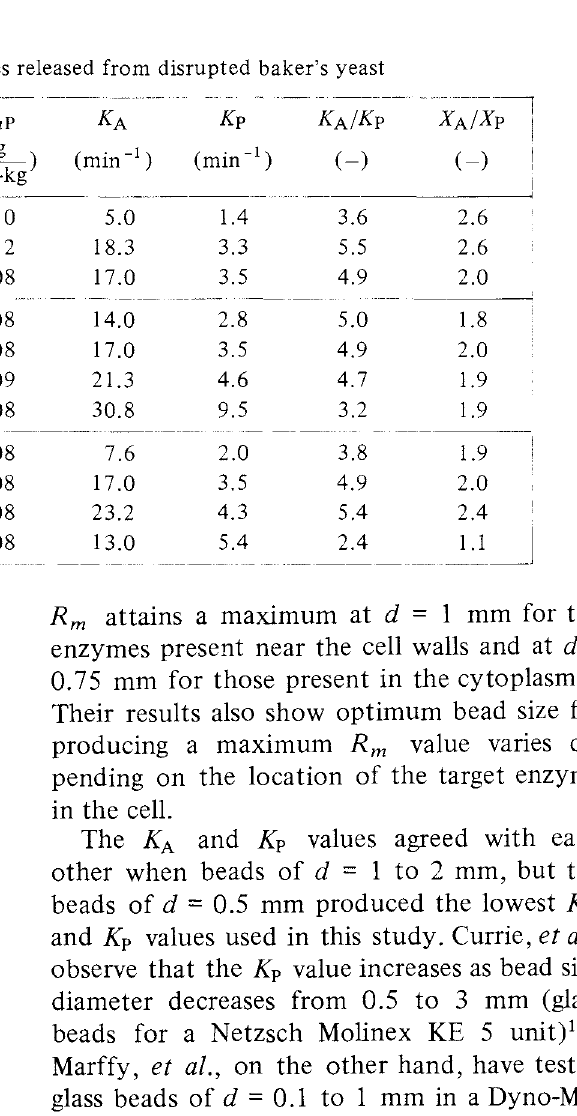
Table 1 Characteristics of substances released from disrupted baker's yeast